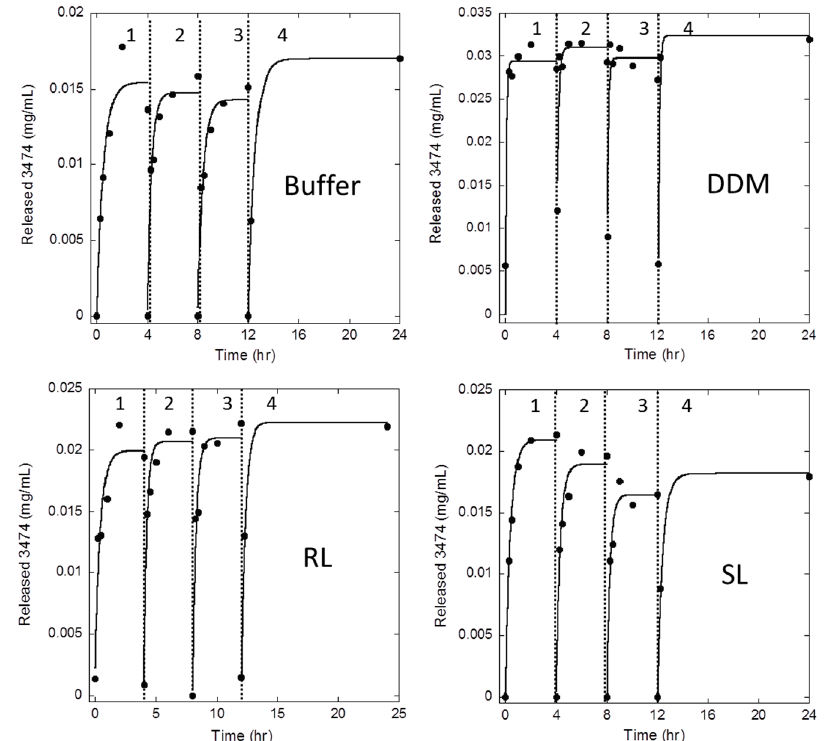
Figure 2. Soluble 3474 is released at the same final level in consecutive release cycles from each type of aggregate. The 3474 aggregates were prepared in the buffer, 10 mM DDM, 10 mM RL, or 10 mM SL and spun down. In each cycle, the aggregate was washed and resuspended in a PBS solution to 1 mg/mL and samples were withdrawn at different time points and centrifuged separately to measure the release of soluble 3474 over time. At the end of each cycle, the aggregate was spun down, and subsequently resuspended in a new cycle. The release of 3474 from different aggregates could all be fitted to a single exponential decay with half-lives of 14–18 min, except for DDM aggregates which reached equilibrium within the first measurement point (see main text). Release figures show release levels in mg/mL from a suspension of originally 1 mg/mL aggregate. Thus, the release figures in mg/mL also correspond to the fraction of release (disregarding the small reduction in total protein after each